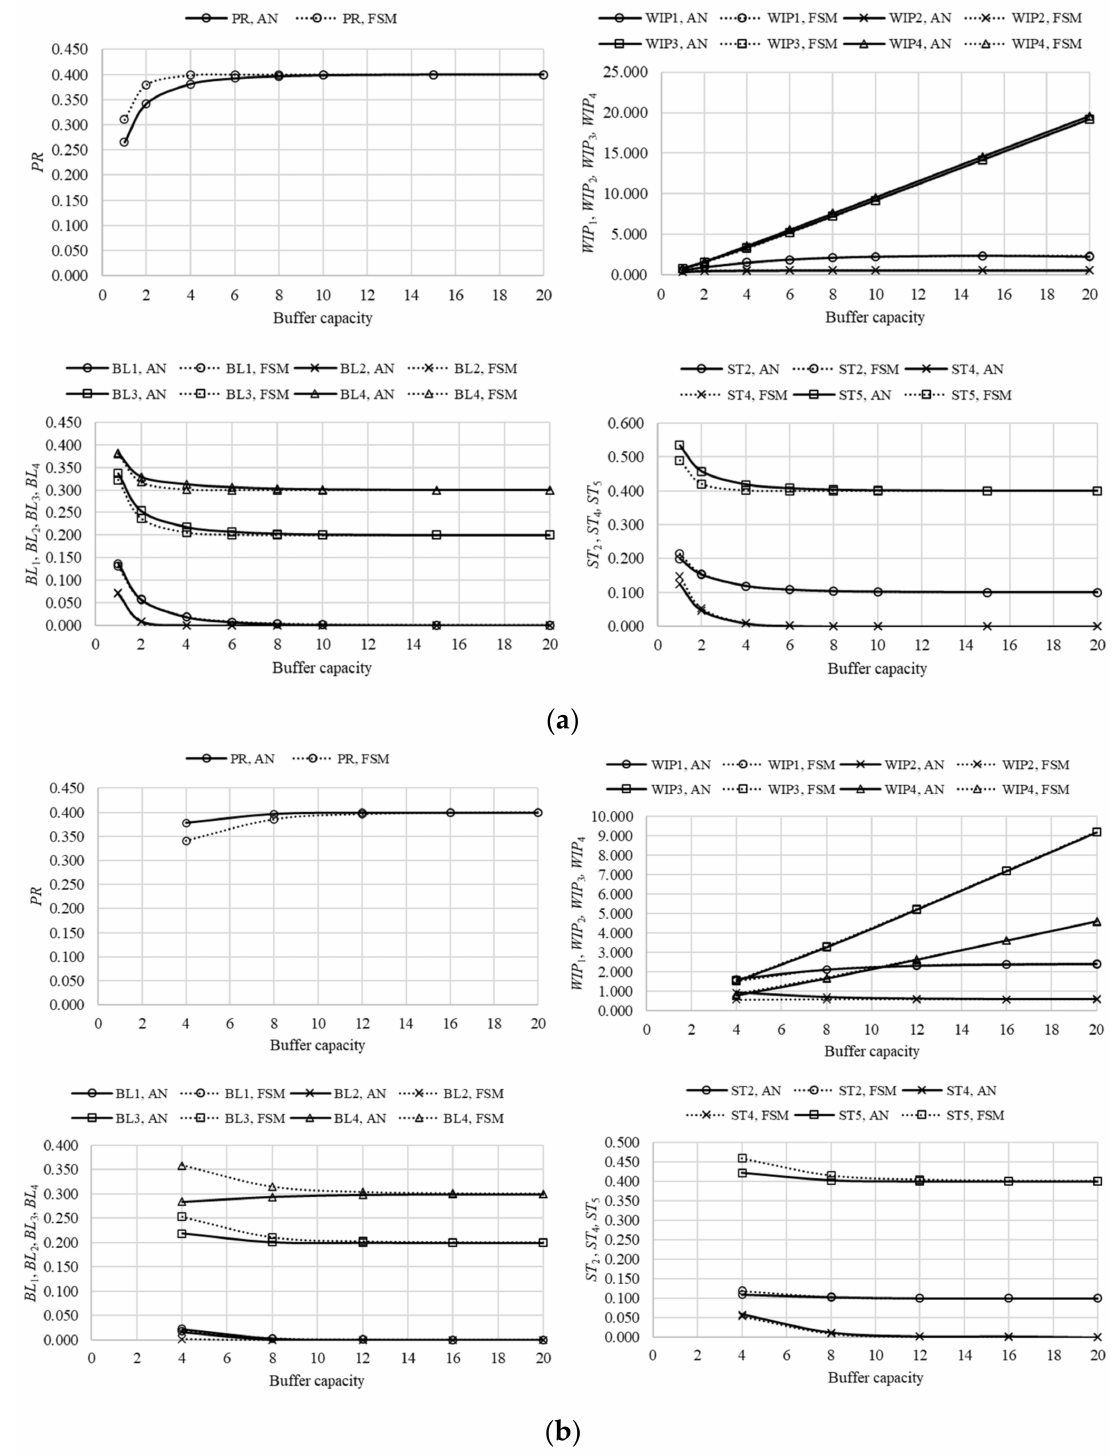
Figure 9. Comparison of the performance measures in the case of line L5A: ( a ) N 1 = N 2 = N 3 = N 4 = N